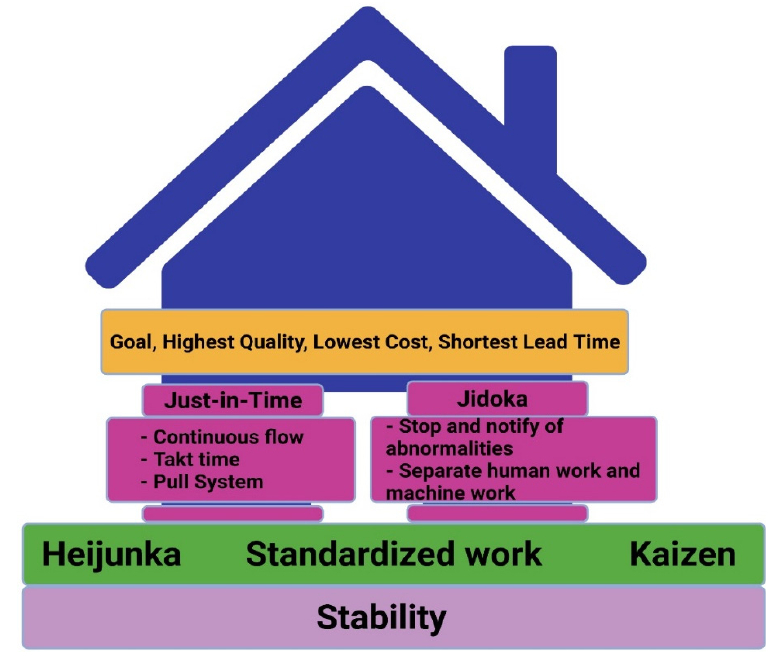
Figure 1. Toyota production system (TPS) of MedTech companies.